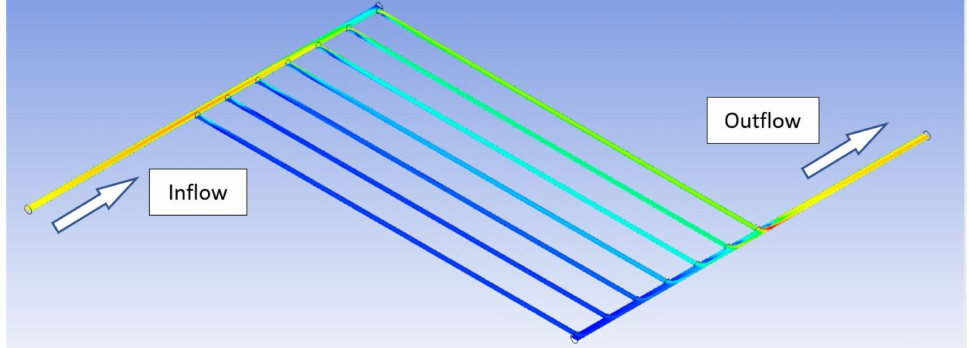
Figure 14. Distribution of air velocity in the axis of individual pipes of a multi-pipe EAHE: blue color—the lowest velocity, yellow to red—the highest; results of own